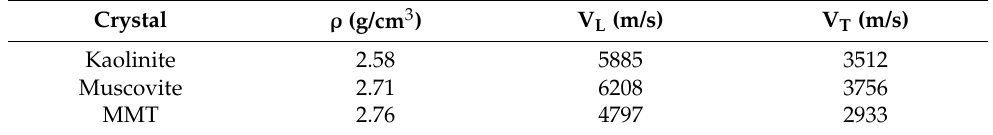
Table 4. Values of density and sound velocities V L and V T . Crystal ρ (g/cm 3 ) V L (m/s) V T